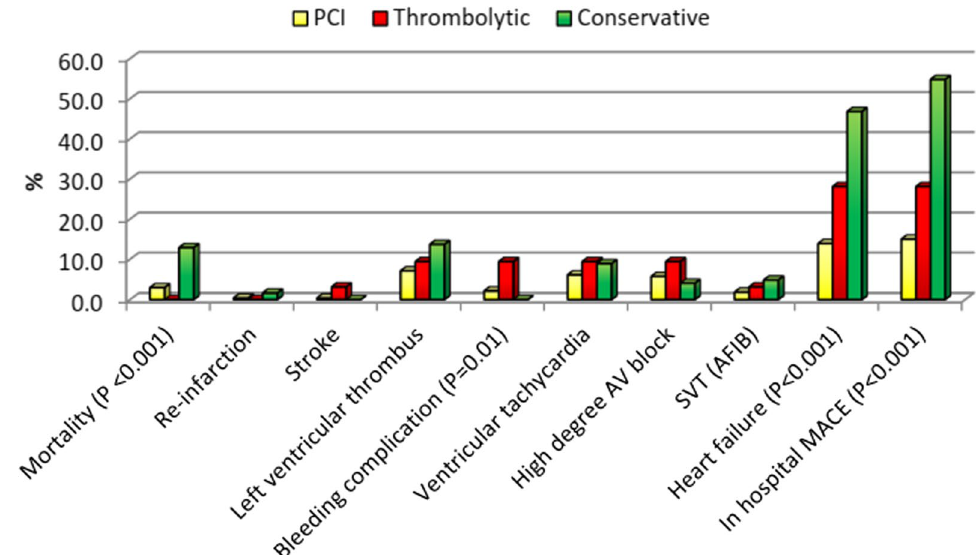
Fig. 1 Comparison between the different studied types of management according to hospital events ( n